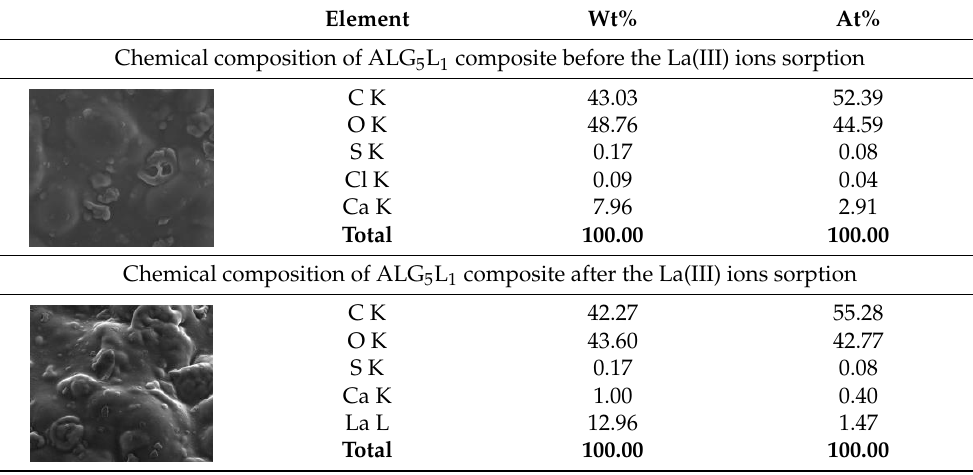
Table 3. EDX analysis results of ALG 5 L 1 composite before and after the La(III) ions sorption. Element Wt% At%